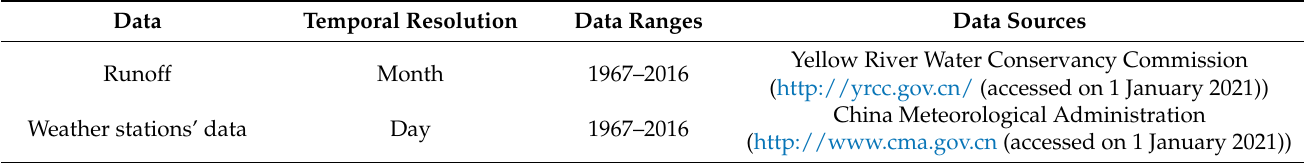
Table 1. The basic information of the five global climate